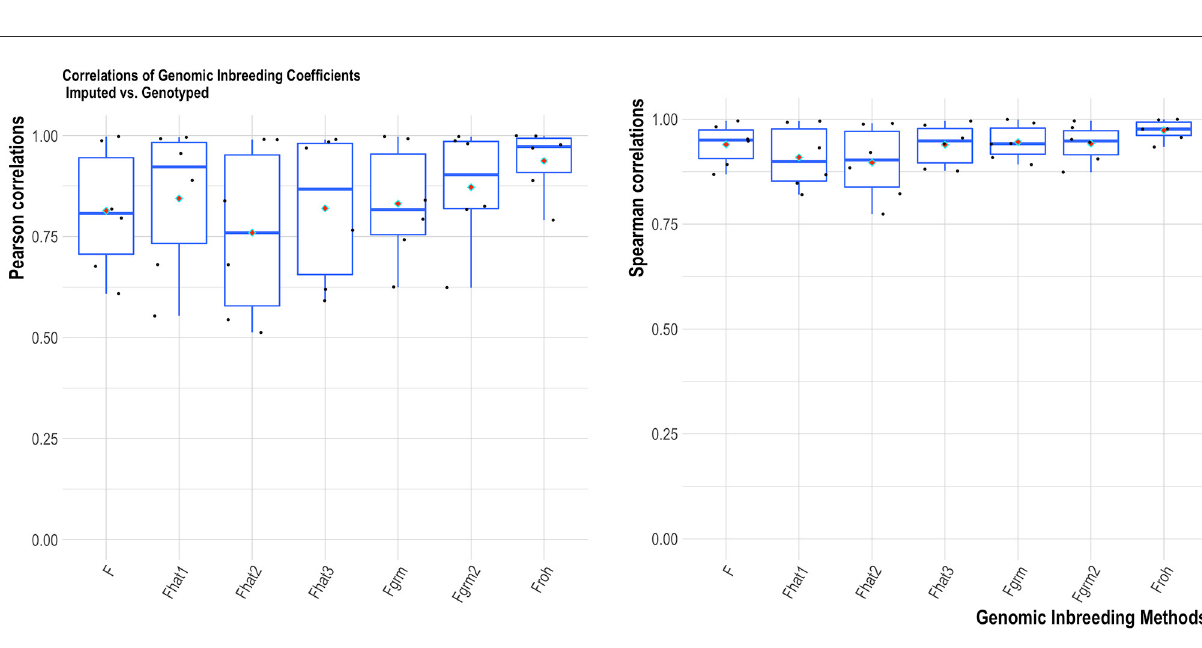
FIGURE4 Average Pearson (left) and Spearman (right) correlations of the tested SNP panels for each genomic inbreeding estimator. Horizontal bars within each boxplot represent the median, and red rhombus the